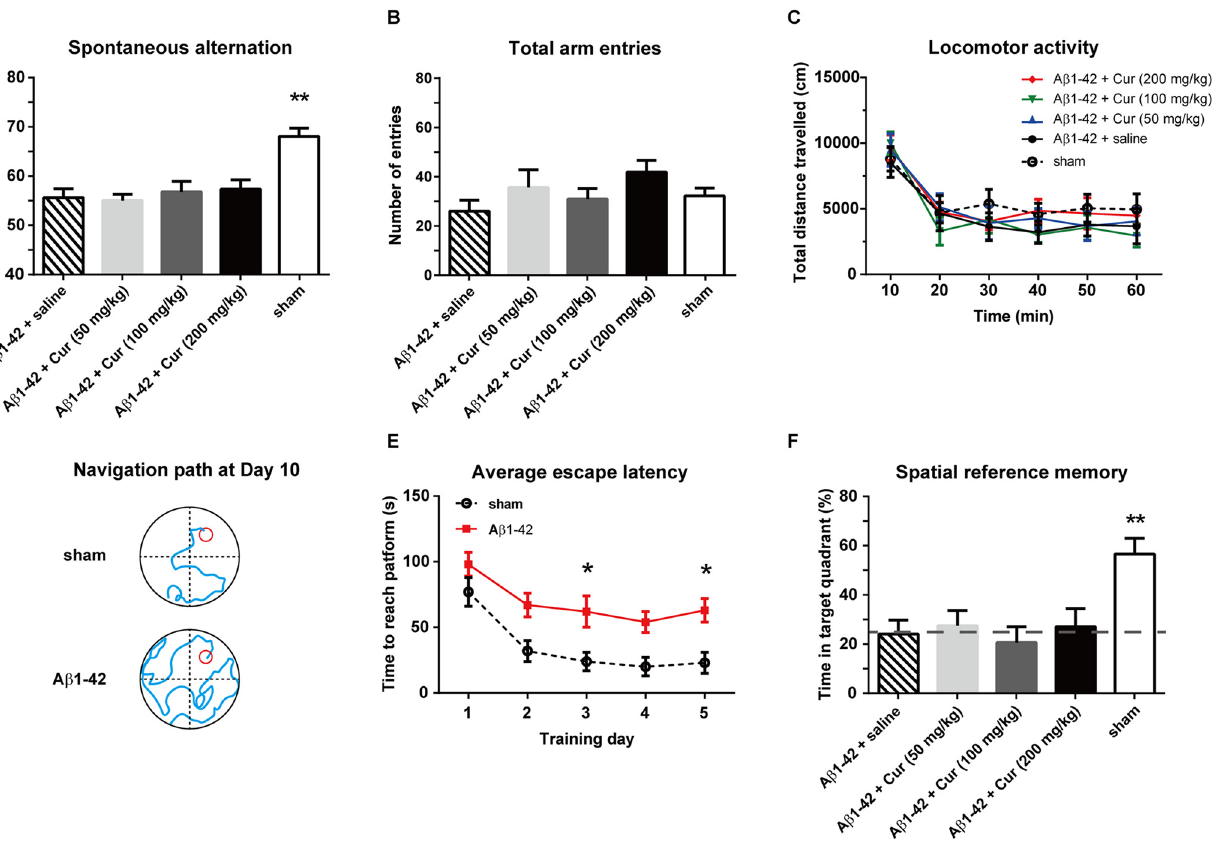
Fig 2. Effect of acute curcumin on working memory, motor function and spatial reference memory in an A β 1-42-treated rat model of Alzheimer's disease. (A) The spontaneous alteration in the Y-maze. (B) The total arm entries in the Y-maze. (C) The total distance travelled in an open-field test. (D) Representative swim traces in the Morris water maze training trial. (E) The escape latency during the water maze training trials. (F) The time spent in the target quadrant in the probe task. n = 8 each group. * P < 0.05 and ** P < 0.01 compared with A β 1 – 42 + saline group